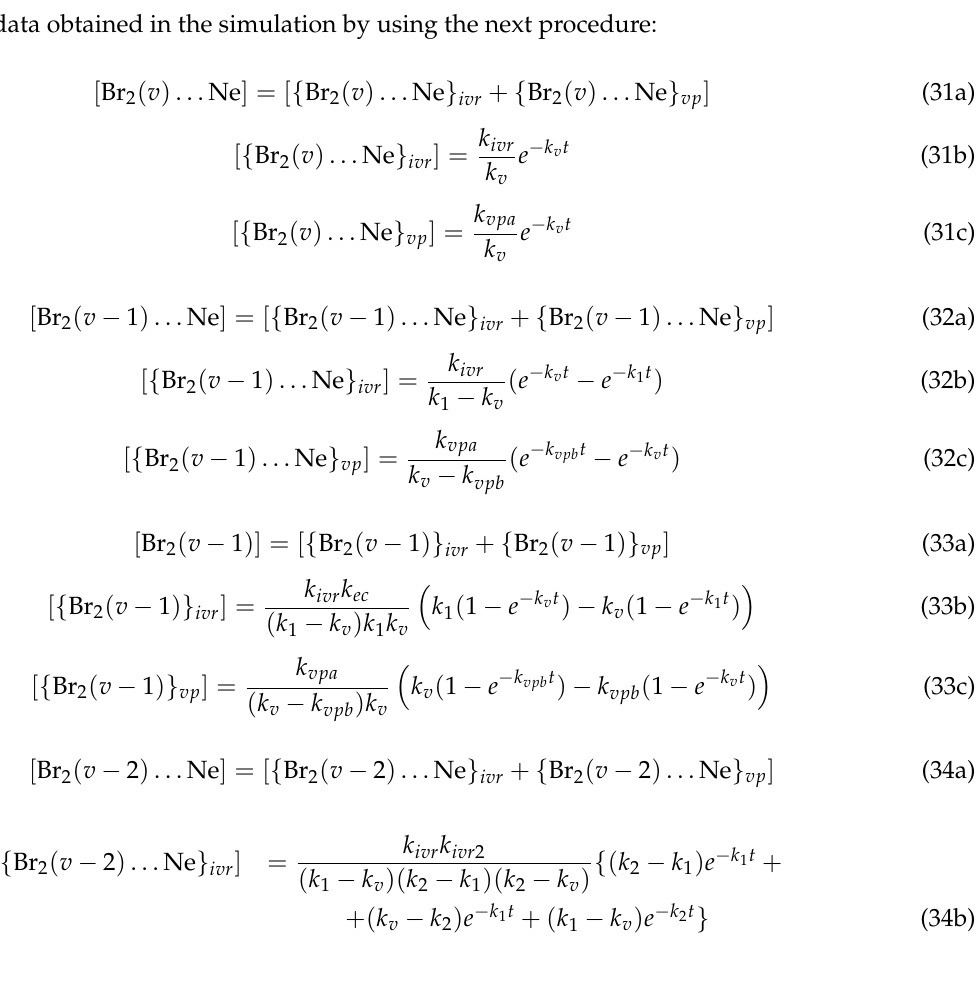
Figure 3. Scheme of kinetic